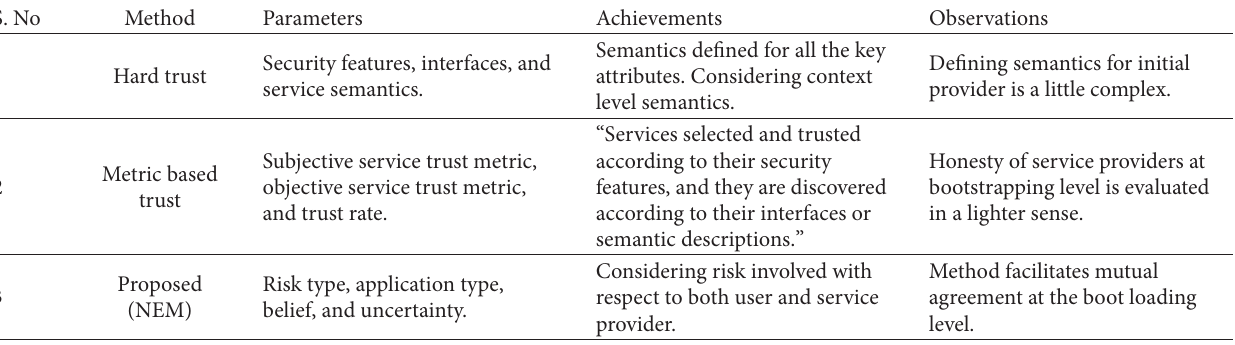
Table 4: Comparison of existing and proposed methods.